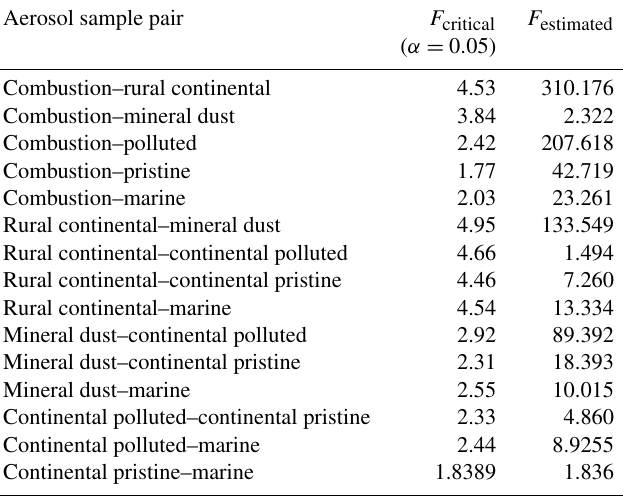
Table A1. Statistical F test analysis of INP concentration at − 15 ◦ C cold stage temperature for pairs of samples. Estimated and critical values of the sample test statistic, F critical and F estimated , for each pair of aerosol samples (Sect. 2.1). When the sample test statistic is less than the critical value, then the pair does not differ